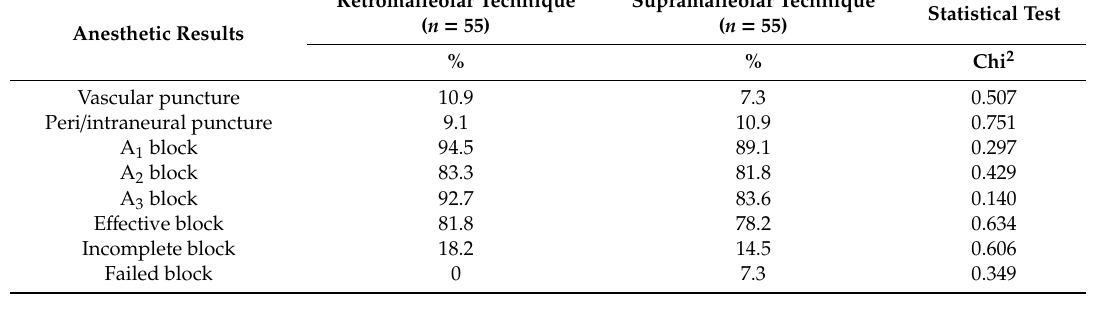
Table 4. Comparison of the anesthetic results achieved with the two techniques.